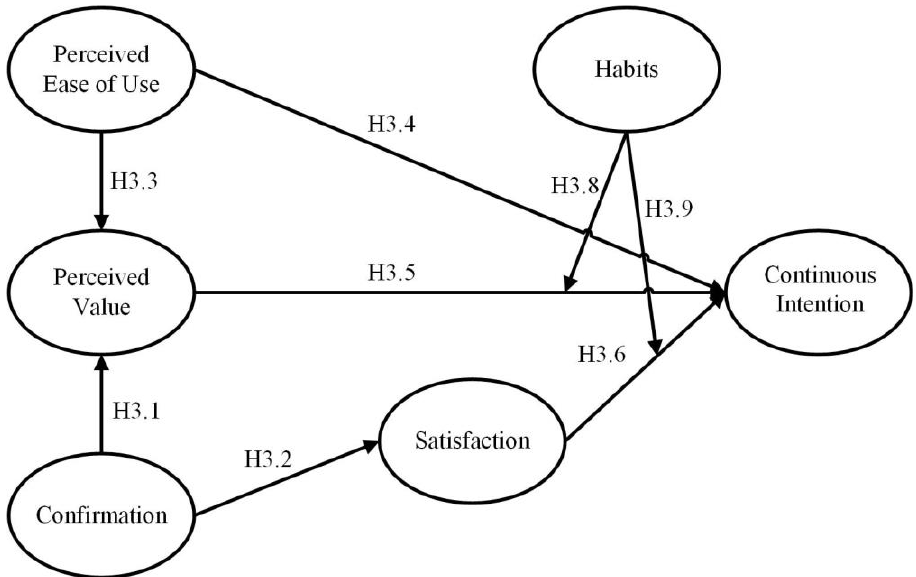
Figure 3. Research Model III (TAM-ECM Integrated Model).